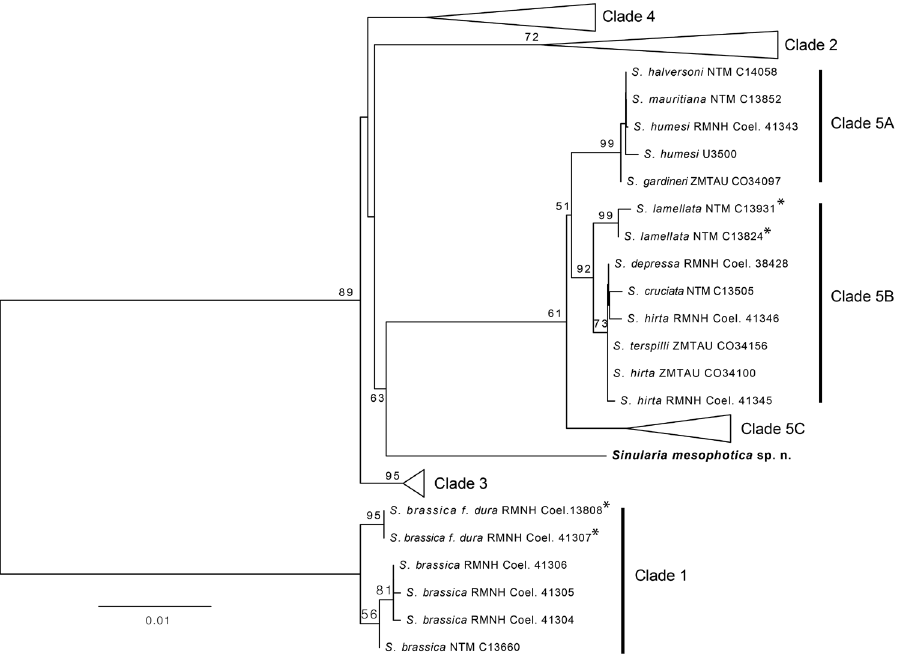
Figure 5. Maximum likelihood tree of concatenated mtMutS and igr1+COI mitochondrial gene sequences. Clade numbering system follows McFadden et al. (2009); some clades have been collapsed to facilitate readability. Asterisks indicate species with a funnel-shaped morphology similar to that of Sinularia mesophotica sp. n. Bootstrap values >50% are indicated adjacent to